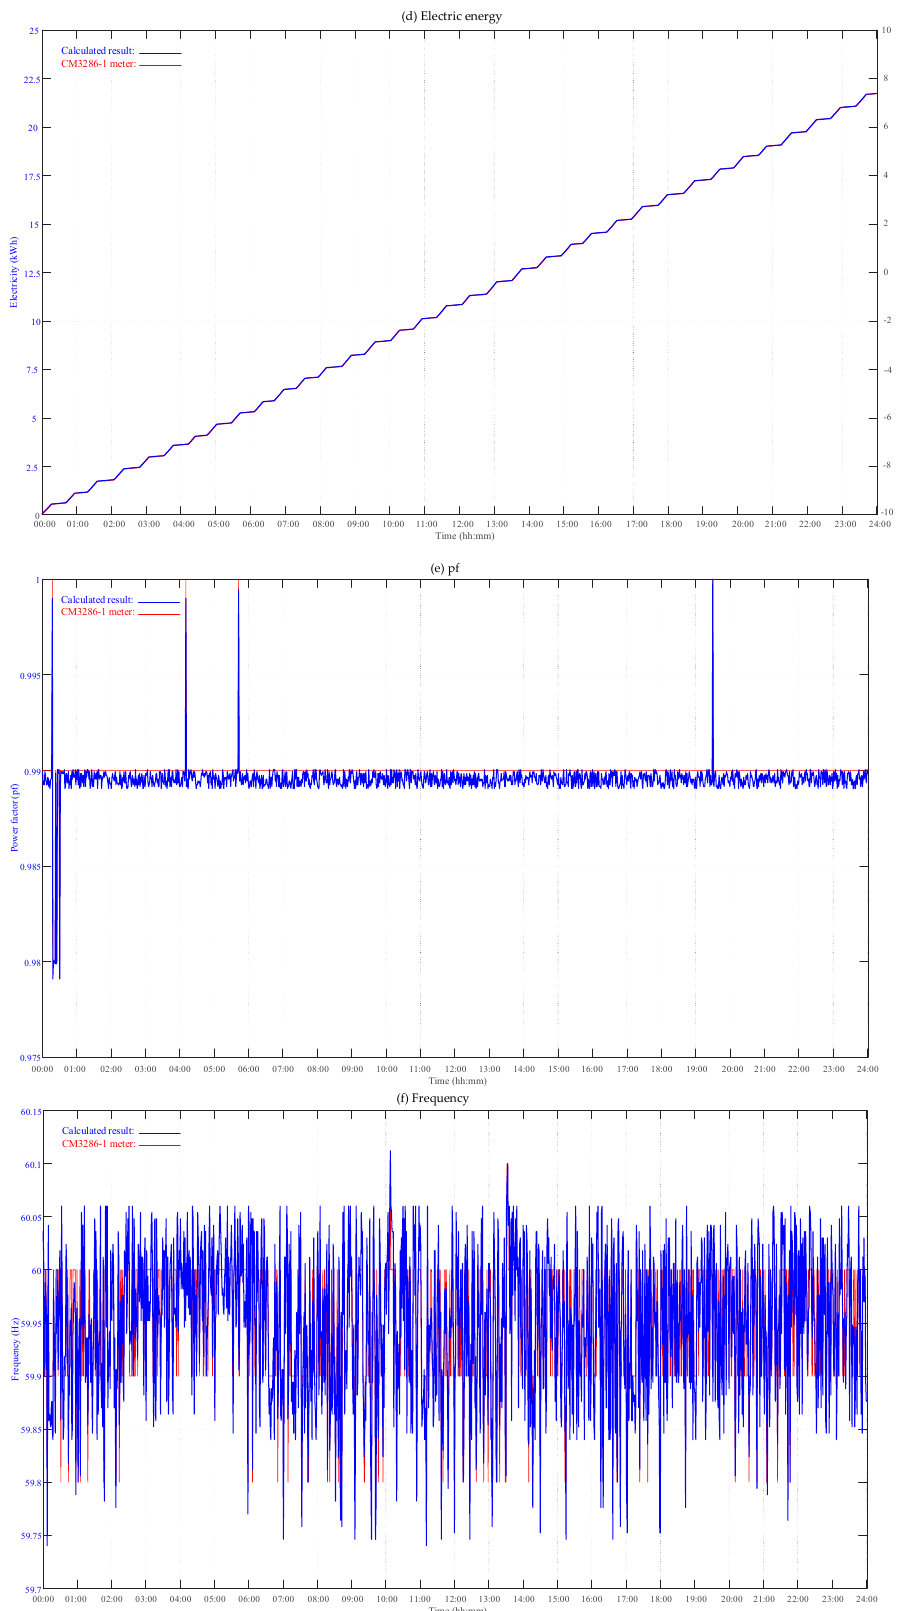
Figure 7. The 24 h measurement results of air conditioner: ( a ) Voltage; ( b ) Current; ( c ) Electric power; ( d ) Electric energy; ( e ) Power factor (pf); ( f ) Frequency (Hz). The close agreement analysis is conducted according to the same procedure as ex- plained above. Taking the measurement results of CM3286-1 instruments as references, the relative difference of the voltage, current, electric power and electricity, pf, and fre- quency between the proposed AC monitoring IoT system and CM3286-1 AC Clamp Power Meter instruments is defined in Equation (9). As shown in Figure 8a, the reading voltage difference between ZMPT101B voltage sensor and CM3286-01 AC Power Meter ranges from ‒ 3.4128 to 0 V.